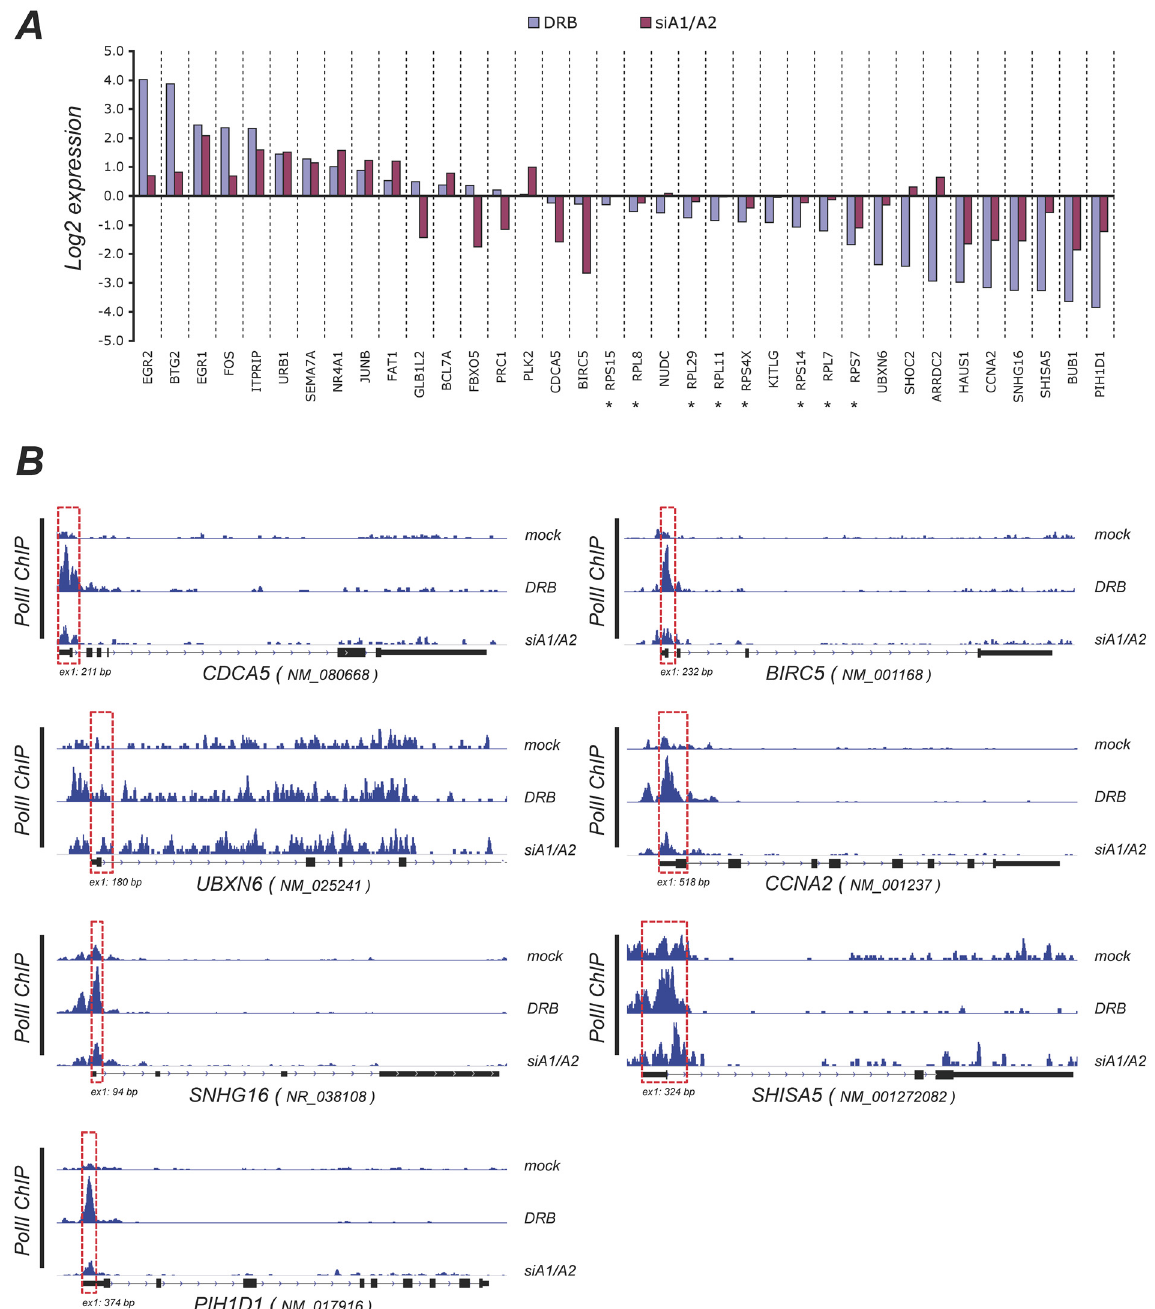
Fig 7. Changes in expression and RNA polymerase II occupancy elicited by DRB and the siRNA-mediated depletion of A1/A2. A , Histograms depicting the difference in expression for selected genes based on reads assignment and normalized for library sizes using TMM normalization. Genes encoding ribosomal proteins are indicated with an asterisk. B , Density of ChIP-seq reads for RNA polymerase II (H-224 antibody) on selected genes (with the major RefSeq transcripts indicated) in mock-treated, DRB-treated and siA1/A2-treated samples. Genes in panel B are transcribed from left to right. The size in bp of the first exon is indicated. Red dashed boxes indicate the promoter-proximal regions displaying an increase in pol II occupancy upon treatment with DRB and the siRNA-mediated knockdown of